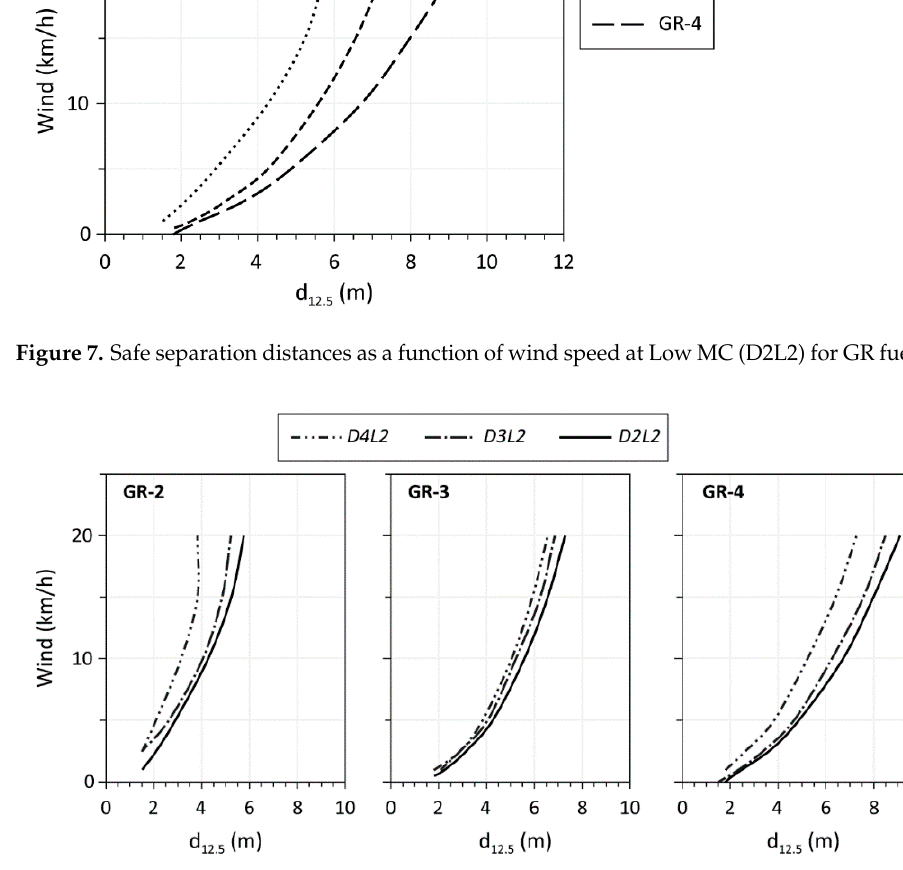
Figure 7. Safe separation distances as a function of wind speed at Low MC (D2L2) for GR fuel mod- els.